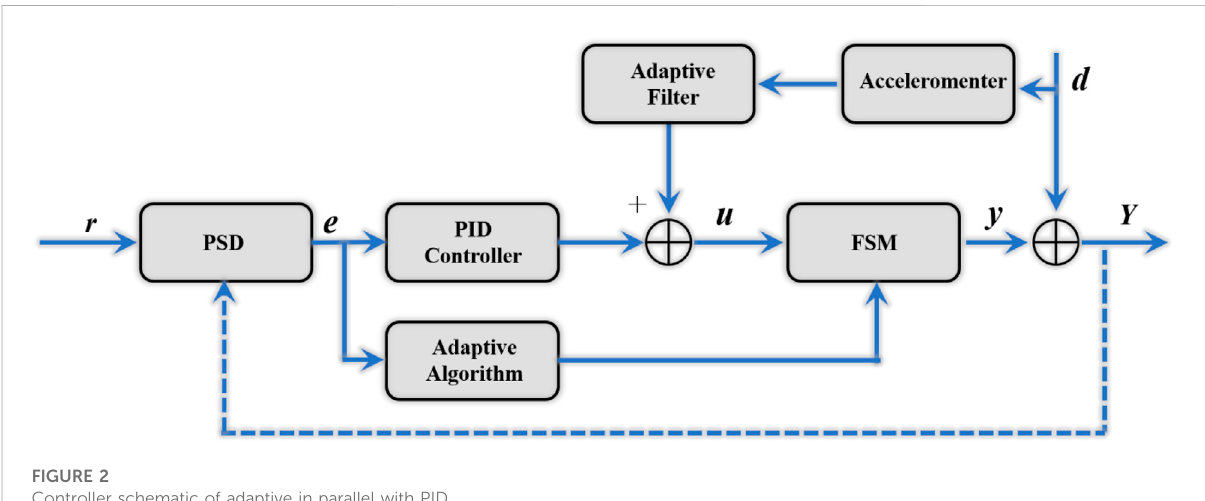
FIGURE 2 Controller schematic of adaptive in parallel with